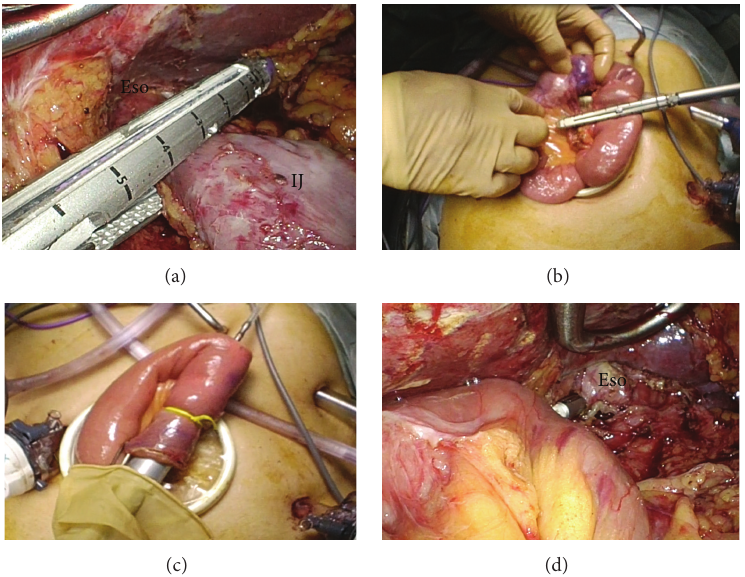
Figure 2: Reconstruction at laparoscopic remnant total gastrectomy. (a) The esophagus was transected using a linear stapler (GIA Tri- Staple 60 mm, purple 60 mm, Covidien) on the proximal side of the anastomosis of the esophagojejunostomy at initial proximal gastrectomy. (b) Jejunojejunostomy was carried out by side-to-side anastomosis using a linear stapler extracorporeally. (c, d) Esophagojejunostomy was performed by an end-to-side anastomosis using a circular stapler (DST Series EEA Staplers, 25 mm, Covidien) intracorporeally (IJ; interposes jejunum, Eso; esophagus).